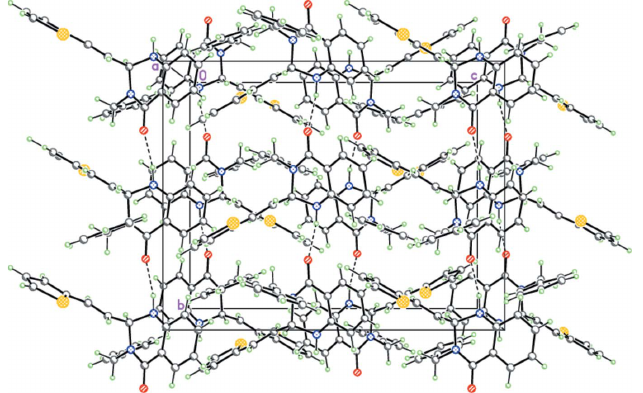
Figure 6 Syntheses of 3-benzyl-2-[( E )-2-(furan-2-yl)ethenyl]-2,3-dihydroquinazo- lin-4(1 H )-one (I) and 3-benzyl-2-[( E )-2-(thiophen-2-yl)ethenyl]-2,3-di- hydroquinazolin-4(1 H )-one